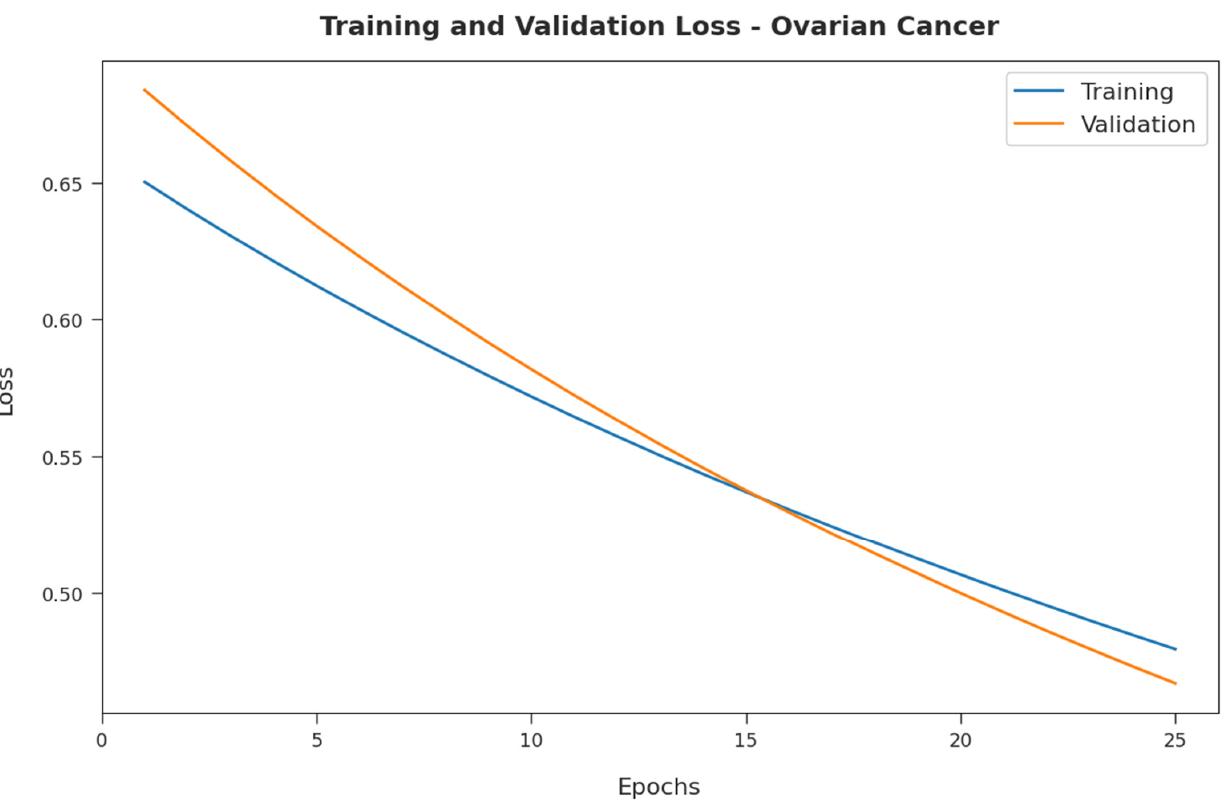
Figure 11. Loss analysis of RFODL-MGEC technique on ovarian cancer dataset.